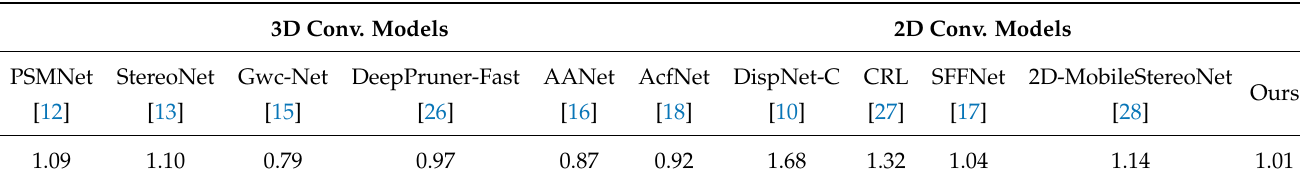
Table 2. Comparison of EPEs of various methods on the Scene Flow test set. 3D Conv. Models 2D Conv.